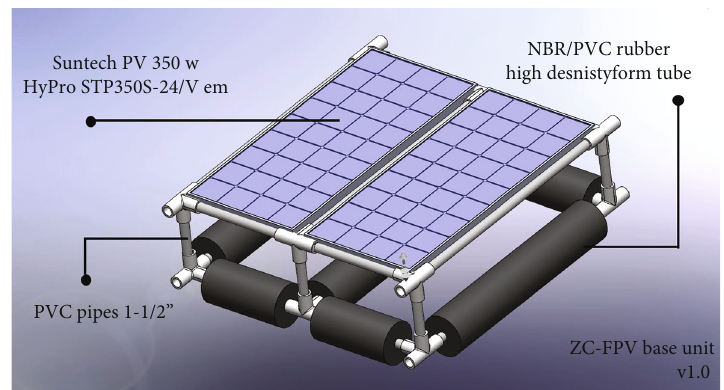
Figure 22: A half unit of a proposed low-cost fl oat PV module. Table 3: The two-tilt angle